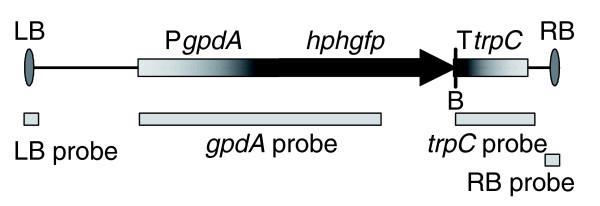
T-DNA of pPK2 hphgfp. LB, left border; PgpdA, Aspergillus nidulans glyceraldehyde-3-phosphate dehydrogenase promoter; hphgfp, translational fusion of hygromycin B resistance gene and green fluorescent protein gene; TtrpC, A. nidulans trpC terminator; RB, right border; B, BamHI restriction site.